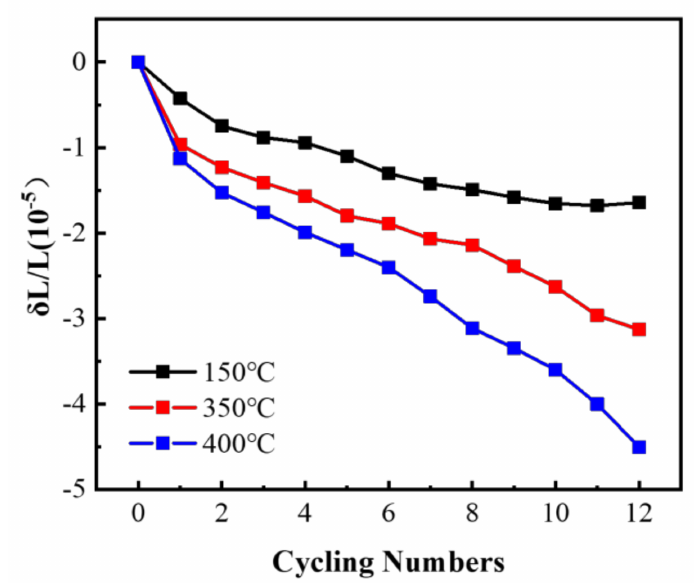
Figure 6. Variation of the residual plastic strain of the sample after annealing with the number of thermal